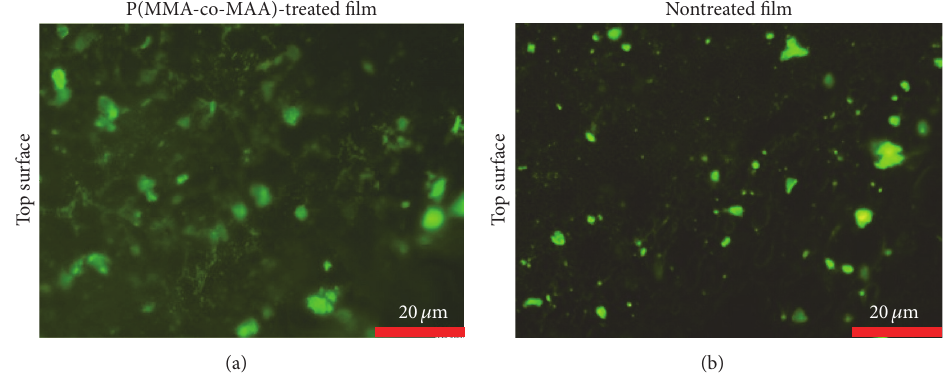
Figure 6: Fluorescence images of the incorporation of siRNA-PEI complex coating on the porous PU films: P(MMA-co-MAA)-treated film (a) and nontreated film (b).